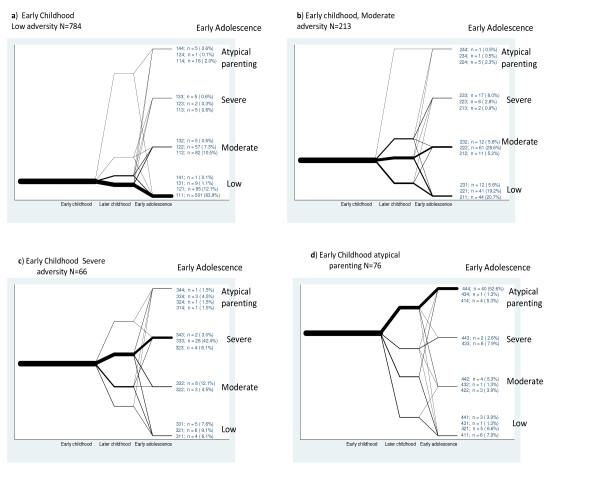
Pathways of early family environment.